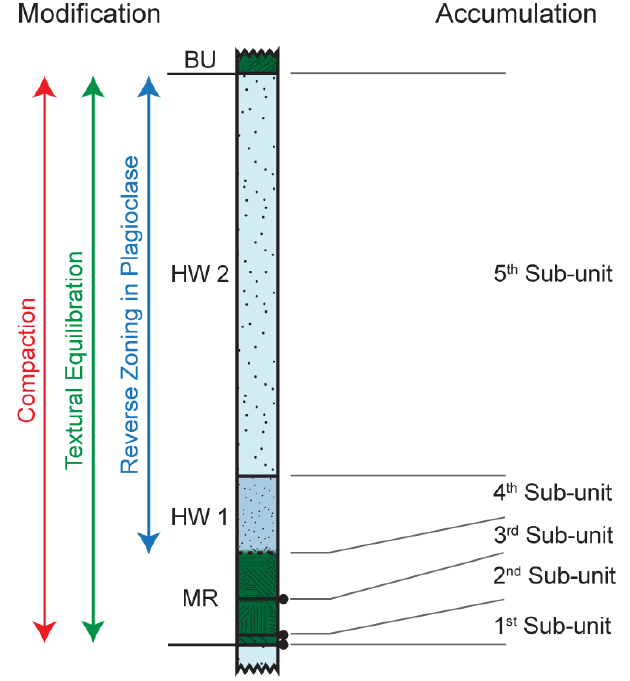
Figure 12. Simplified model indicating, on the right, the minimum number of replenishment events involved within the accumulation of the Merensky Unit and thus, the minimum number of sub-units. On the left, processes and events that modified the Merensky Unit are shown, with (1) development of reversely zoned plagioclase in the leuconorite and poikilitic anorthosite; (2) textural equilibration; and (3) compaction.